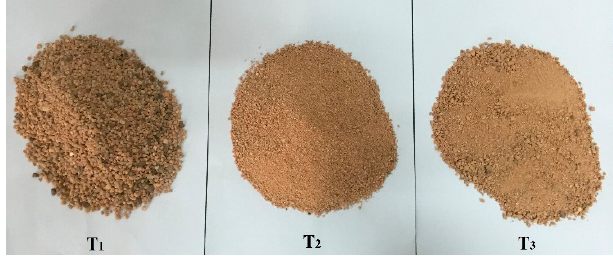
Figure 3. The soil sample (the tailings of ionic type rare earth leached in situ).